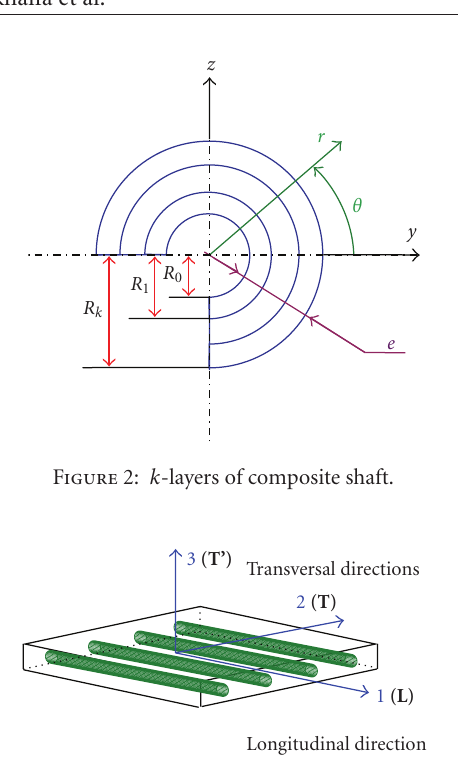
Figure 3: A typical composite lamina and its principal axes.